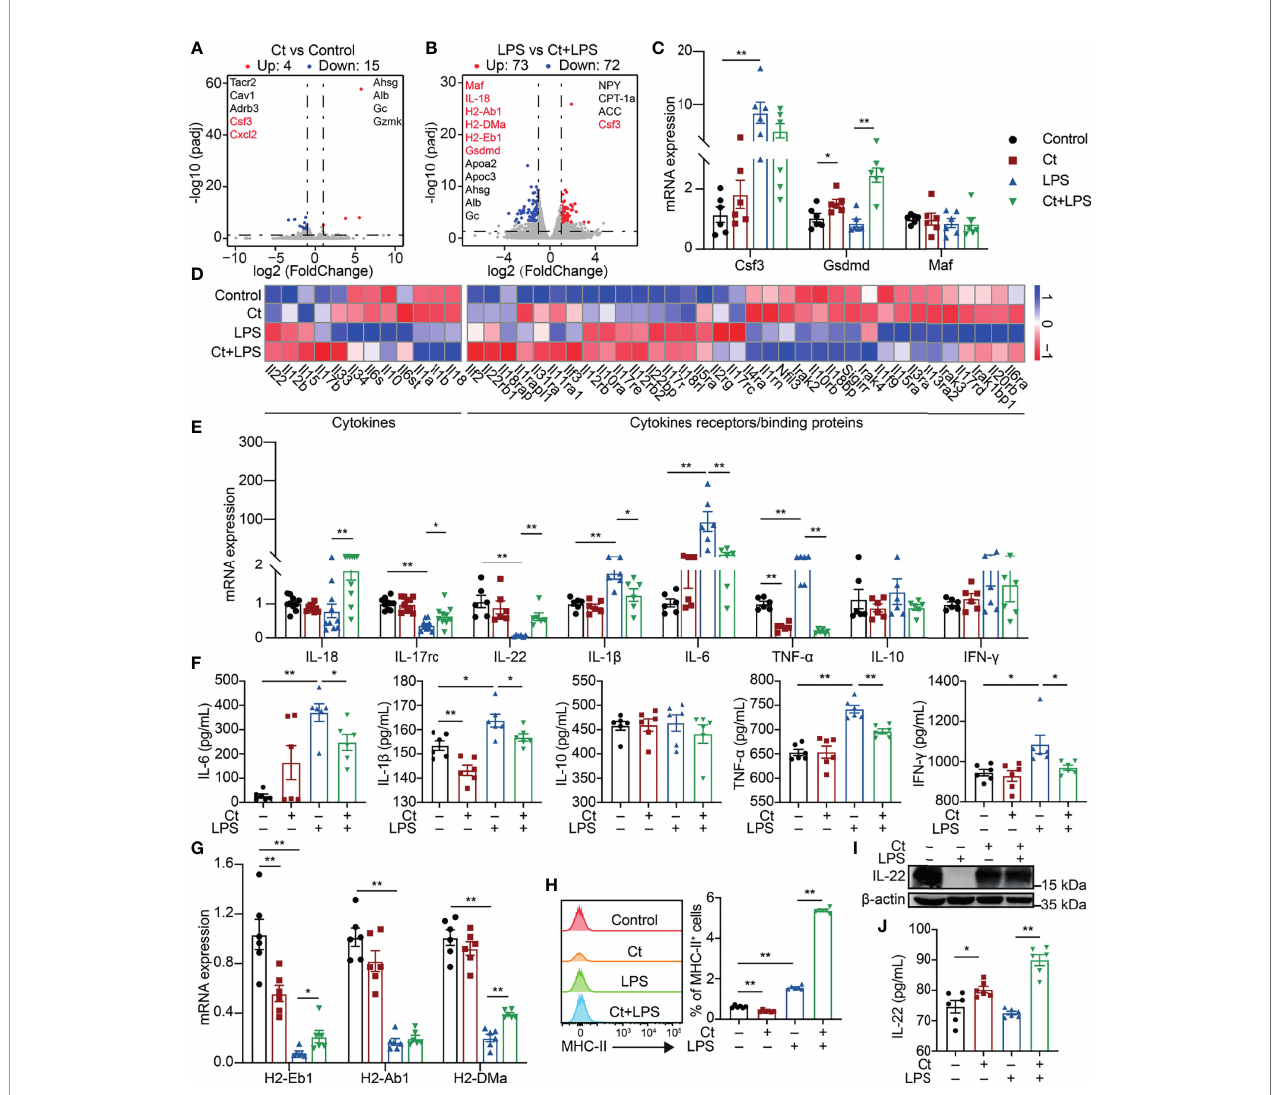
FIGURE 2 | Ct enhances the expression of IL-22 in response to LPS. (A) Volcano plots of differentially expressed genes between the Control and Ct group (Ct vs Control, n=6). (B) Volcano plots of differentially expressed genes between the LPS and Ct + LPS group (LPS vs Ct + LPS, n=6). (C) RT-qPCR analysis of Csf3, Gsdmd, and Maf in the ileum (n=6). (D) Heat-map of differentially expressed genes enriched in cytokines and cytokine receptors/binding proteins. (E) RT-qPCR analysis of cytokines including IL-18, IL-17rc, IL-22, IL-1 b , IL-6, TNF- a , IL-10, and IFN- g in the ileum (IL-18 and IL-17rc, n=10, others, n=6). (F) The levels of in fl ammatory cytokines including IL-6, IL-1 b , IL-10, TNF- a , and IFN- g in the ileum (n=6). (G) RT-qPCR analysis of MHC-II transcripts in the ileum (n=6). (H) Proportions of MHC-II + cell in the ileum (n=6). (I) Immunoblotting analysis of IL-22 in the ileum. (J) ELISA analysis of IL-22 levels in the ileum (n=6). Data were presented as mean ± SEM. The signi fi cant difference was analyzed by two-way unpaired t-tests. * P < 0.05, ** P <